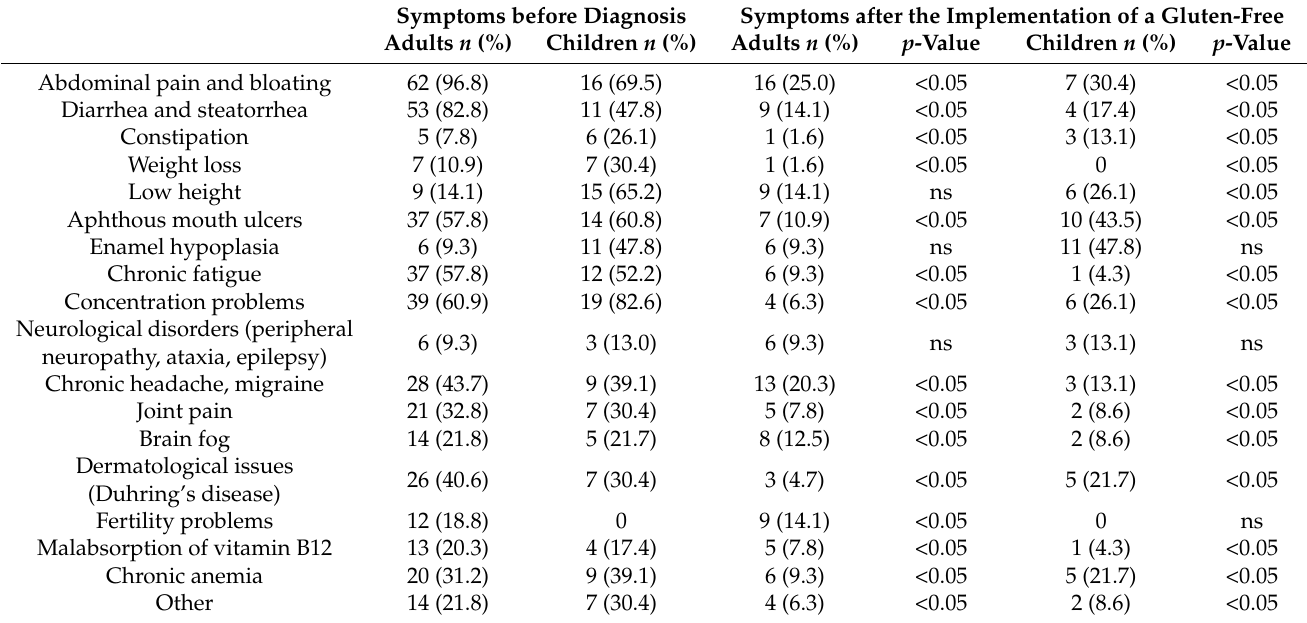
Table 2. Frequency of the main symptoms before and after diagnosis celiac